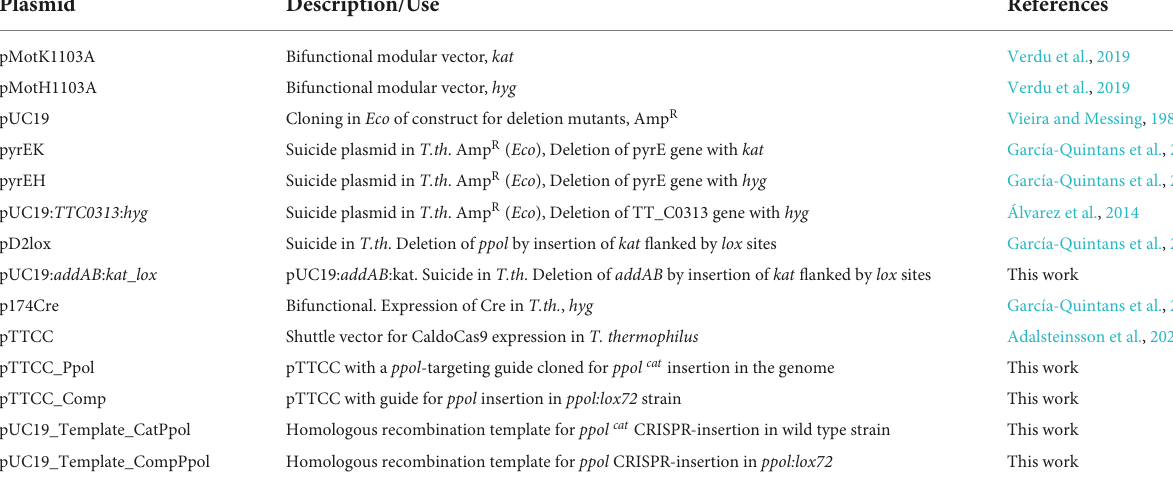
TABLE 4 Plasmids used this